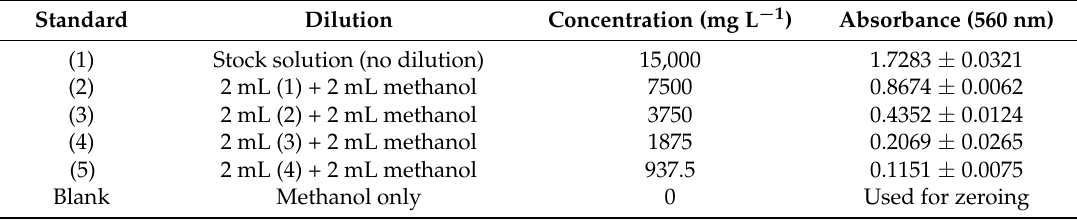
Table 5. Preparation of the aescin standard curve for the modified